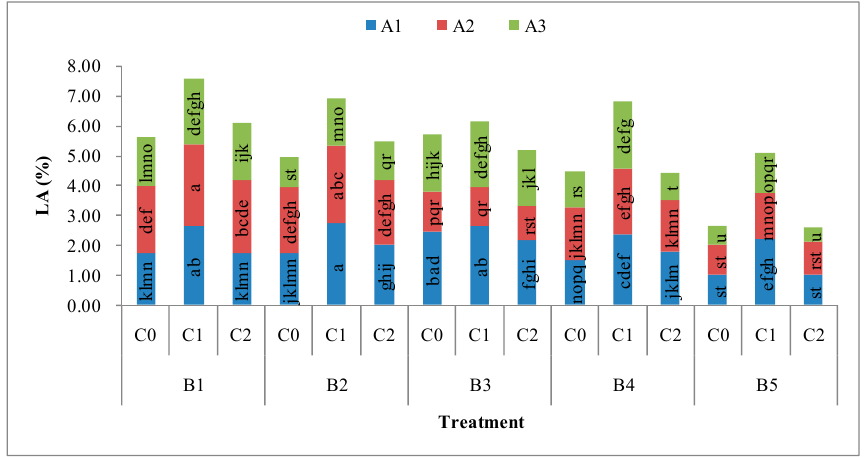
Figure 6. Differences in LA content for the interaction between forage species, cutting stage and additive. LA: lactic acid. A1: triticale; A2: rye; A3: oat; B1: heading stage; B2: flowering stage; B3: grouting stage; B4: milky stage; B5: dough stage; C0: additive-free treatment; C1: Sila-Max; C2: Sila-Mix. a b c d e et al. indicated the significant difference level between treatments ( p < 0.05). If all marked letters between the two treatments had a same letter, the difference between the two treatments was not significant, and if the marked letters were all different between the two treatments, the difference was